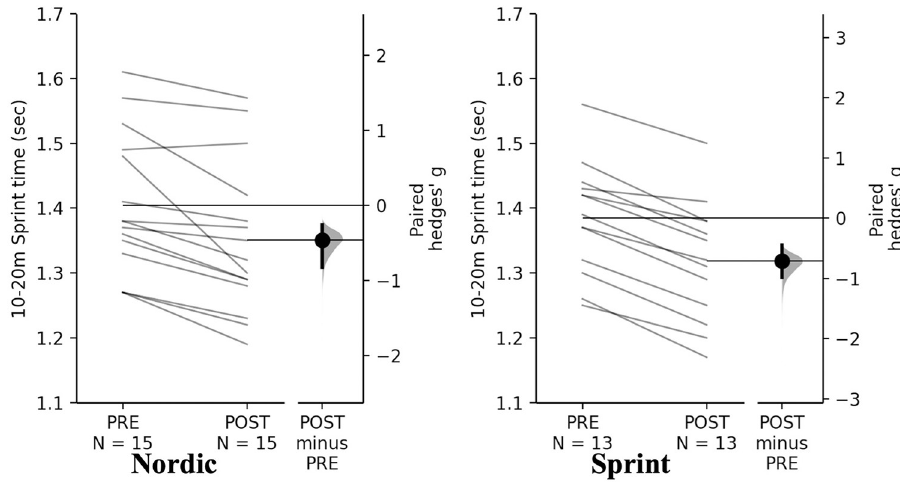
Fig 12. Gardner-Altman estimation plots identifying Pre- and Post-intervention individual changes for 10-20m sprint time and Hedge’s g effect size with the 95% CI indicated by the ends of the vertical error bar.